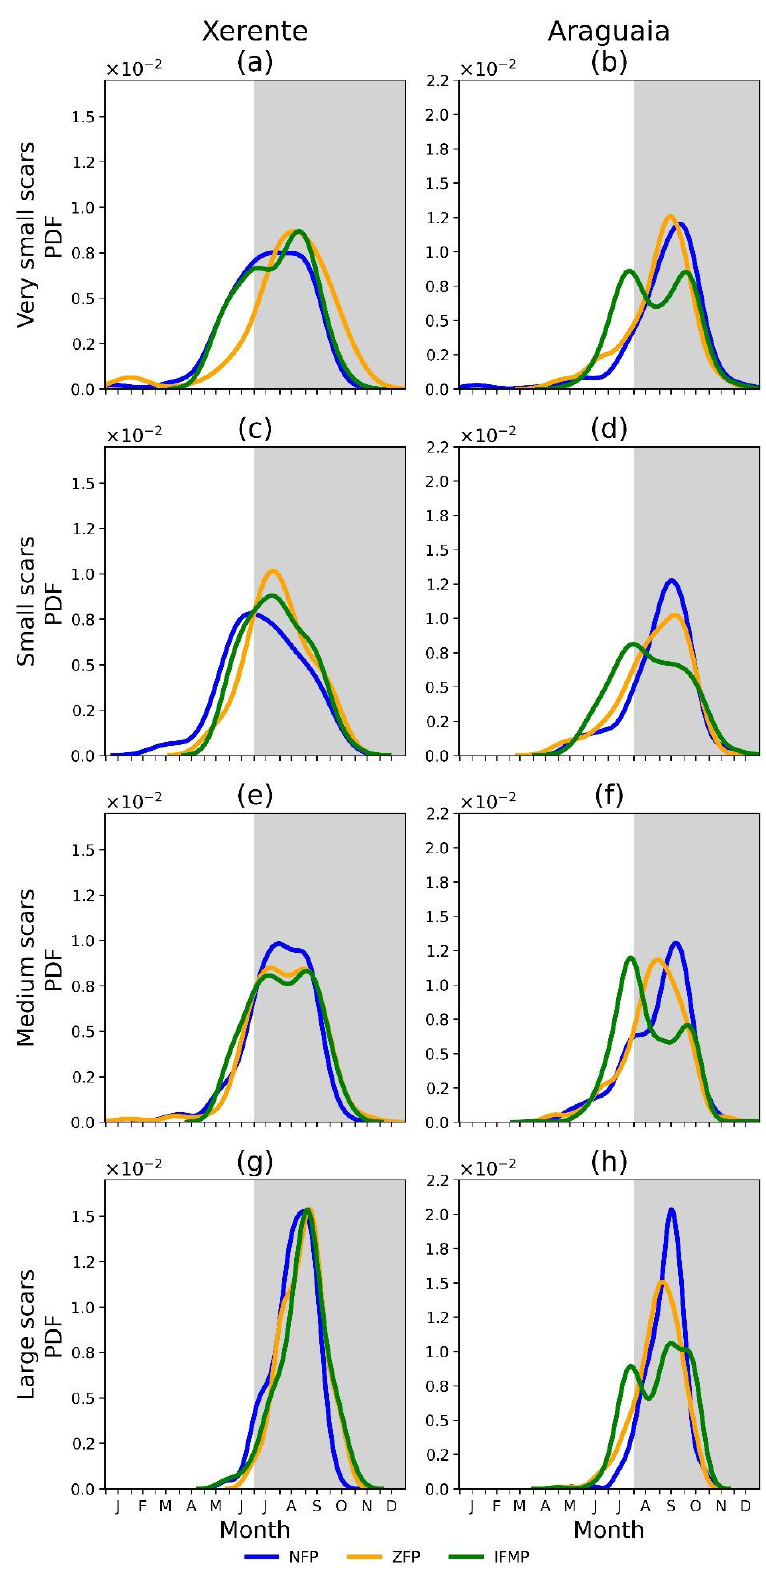
Figure 6. Seasonal distribution of fire scars from 2003 to 2018 per size class in Xerente ( left column ) and Araguaia ( right column ): very small (VS, a , b ), small (S, c , d ), medium (M, e , f ) and large (L, g , h ) for the three phases. The grey column represents WFS.